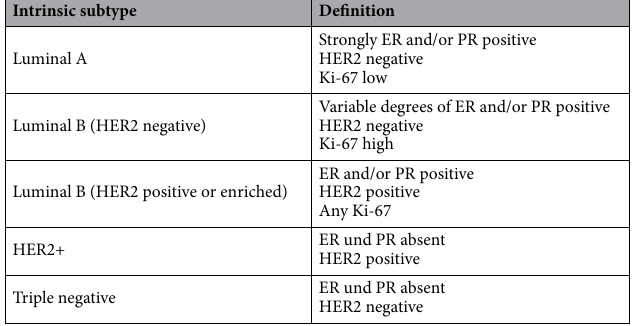
Table 1. Definitions of intrinsic subtypes of breast cancer. ER, oestrogen receptors; PR, progesterone receptors; HER2, human epidermal growth factor receptor